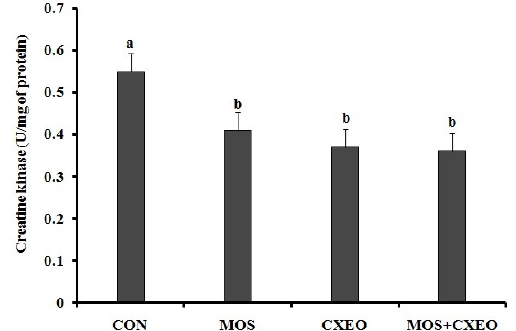
Figure 1. Effect of mannan oligosaccharide (MOS) and Curcuma xanthorrhiza essential oil (CXEO) on creatine kinase (expressed as U/mg of protein) level of chicken breast muscle. Mean values represent the average of 12 observations (six replicates × 2 birds/replicate). Values are means ± SEM. Within the graph, bars with different letters (a, b) are significantly different ( P < 0.05). CON = control group fed no additive. Other groups were fed 5 g/kg of MOS (MOS); or 400 mg/kg of CXEO (CXEO); or 5 g/kg of MOS + 400 mg/kg of CXEO (MOS+CXEO), respectively.